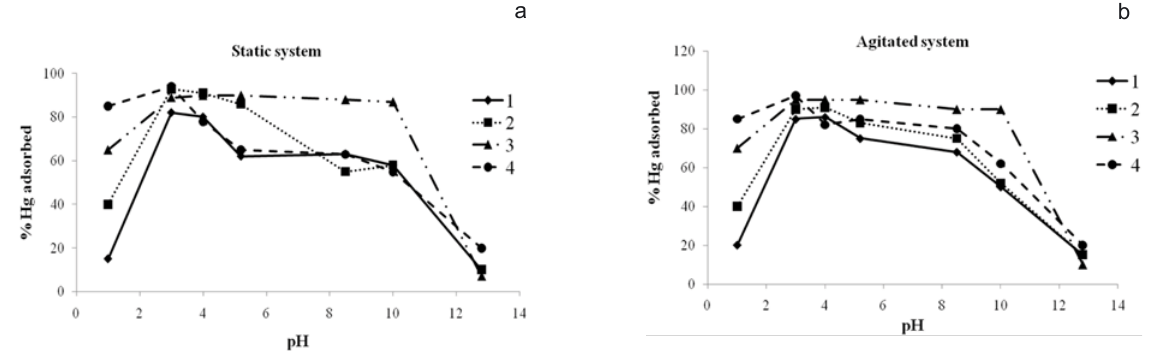
Figure 3. Effect of pH (static system and agitated system, 20 g of ZL 1606 sediment, 250 mL of water, Hg concentration 0.2 mg L -1 , T = 22.3°C); (1) MeHg + , (2) EtHg + , (3) PhHg + , (4) Hg 2